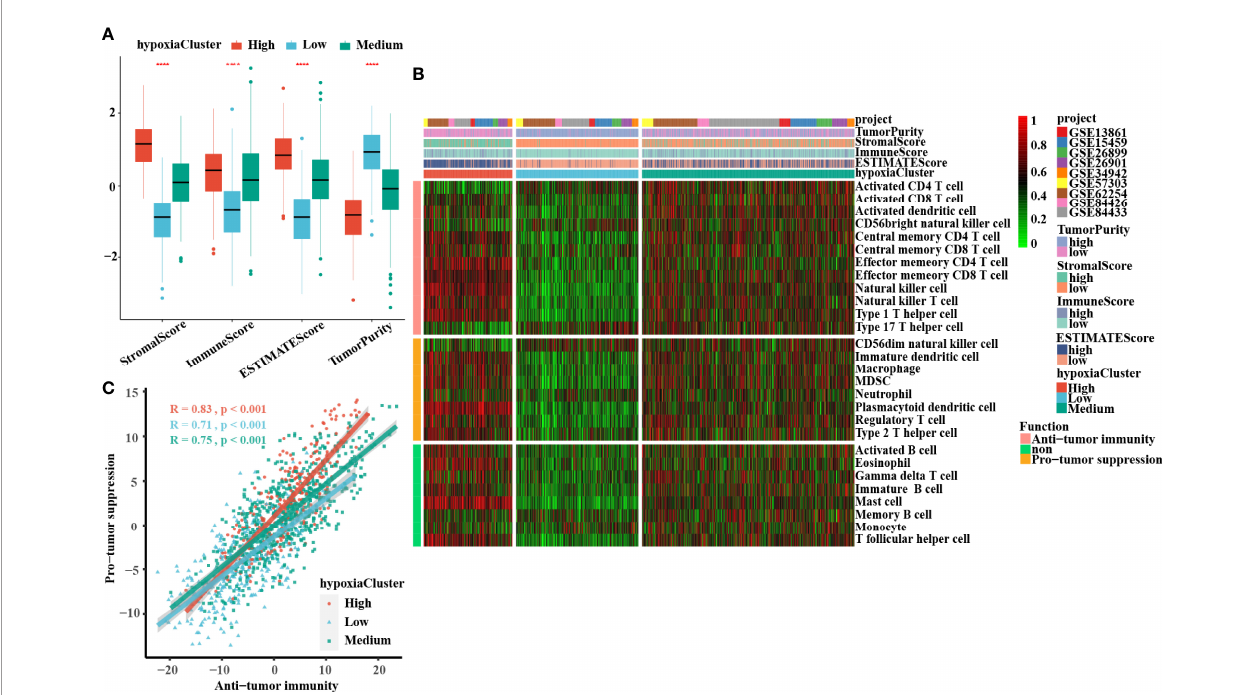
FIGURE 3 | Landscape of the TME between distinct hypoxia status in GC. (A) The boxplots of the ESTIMATE method were used to explore the TME characteristics among these distinct hypoxia clusters, suggesting that hypoxia-cluster high had the highest stromal score, immune score, and ESTIMATE score but the lowest tumor purity (all P-values < 0.0001). The lines in the boxes represented median value. (B) The heatmap depicted the in fi ltrating difference of 28 immune cell types in 3 hypoxiaClusters. HypoxiaCluster-high had a higher abundance of immune cell in fi ltration, including cells performing an anti-tumor function (e.g., effector memory CD4 T cells, effector memory CD8 T cells, natural killer cells, natural killer T cells, and type 1 T helper cells) and cells executing pro-tumor suppression (e.g., immature dendritic cells, macrophages, MDSCs, neutrophils, plasmacytoid dendritic cells, regulatory T cells, and type 2 T helper cells). Moreover, hypoxia-cluster high was signi fi cantly rich in innate immunocyte in fi ltration including natural killer cells, macrophages, mast cells, MDSCs, and plasmacytoid dendritic cells. (C) The correlation between pro-tumor suppression and anti-tumor immunity was analyzed according to 3 hypoxiaClusters, respectively. Pearson ’ s correlation analysis suggested that the abundances of these two categories of immunocytes have a signi fi cant positive association in TME (all P-values < 0.001). The asterisks represented the statistical p-value (****p < 0.0001). The Kruskal – Wallis test was used to compare the statistical difference between three gene